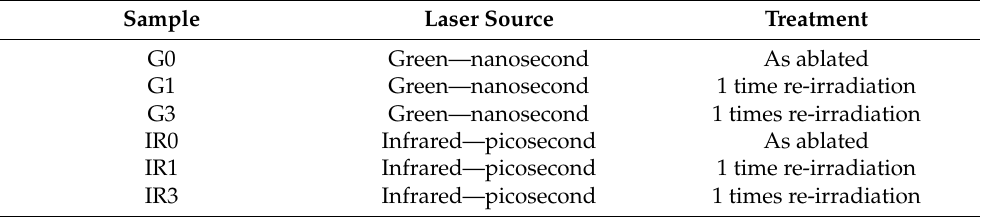
Figure 6. UV-VIS spectra of Ag nanoparticles obtained. Processing conditions correspond with those shown in Table 1. Table 3. Ag-NPs produced and